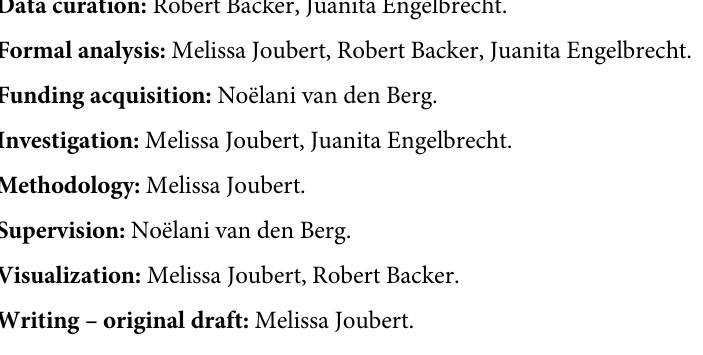
S7 Table. List of functionally characterised RxLR effectors in oomycete species used in phylogenetic analyses. S1 Appendix. List of references used for characterised RxLR effectors listed in S7